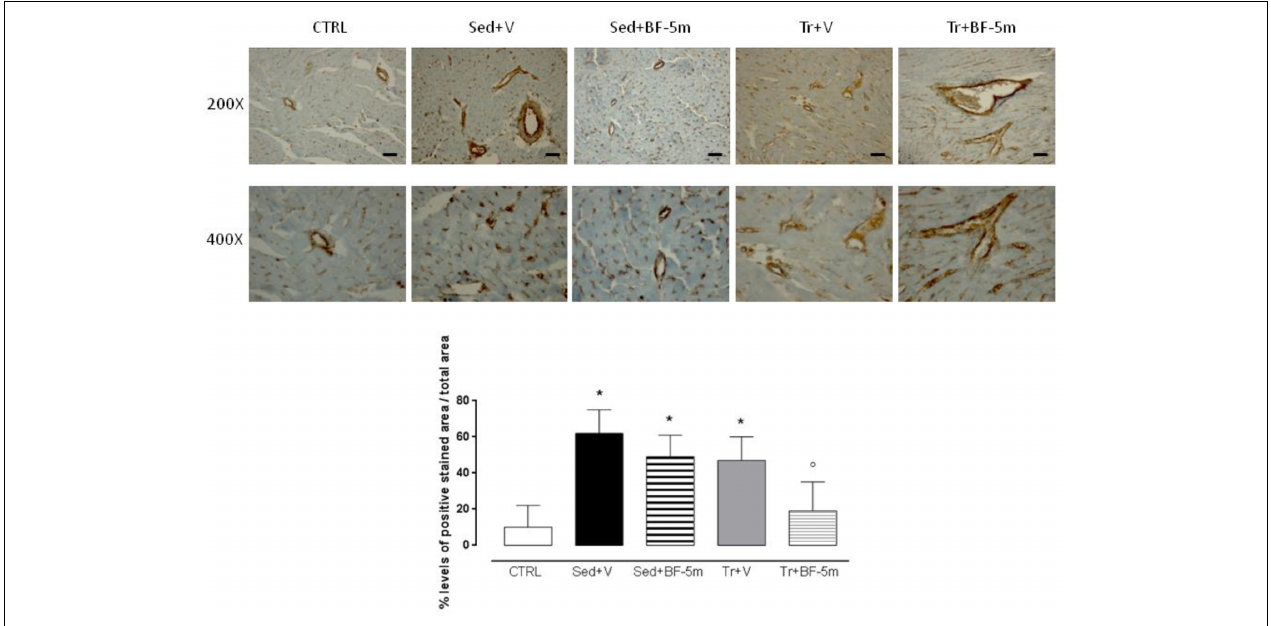
FIGURE 6 | Heart pericapillary fibrosis and interstitial mesenchymal cells after 8 weeks of diabetes following staining with anti-vimentin antibody have been observed increased in the sedentary groups and in untreated trained rats. Prolonged moderate exercise training in association with BF-5m treatment causes a significant reduction in the percentage of fibrosis as shown by vimentin staining at 200X and 400X magnification. Results are reported as mean of five preparations ± S.E.M. CTRL, healthy control rats; Sed+V, diabetic sedentary rats treated with vehicle; Sed+BF-5m, diabetic sedentary rats treated with BF-5m 20 mg/kg; Tr+V, diabetic trained rats treated with vehicle; Tr+BF-5m, diabetic trained rats treated with BF-5m 20 mg/kg/day; Scale bar = 100 µ m; ∗ P < 0.05 vs. CTRL; ◦ P < 0.05 vs.